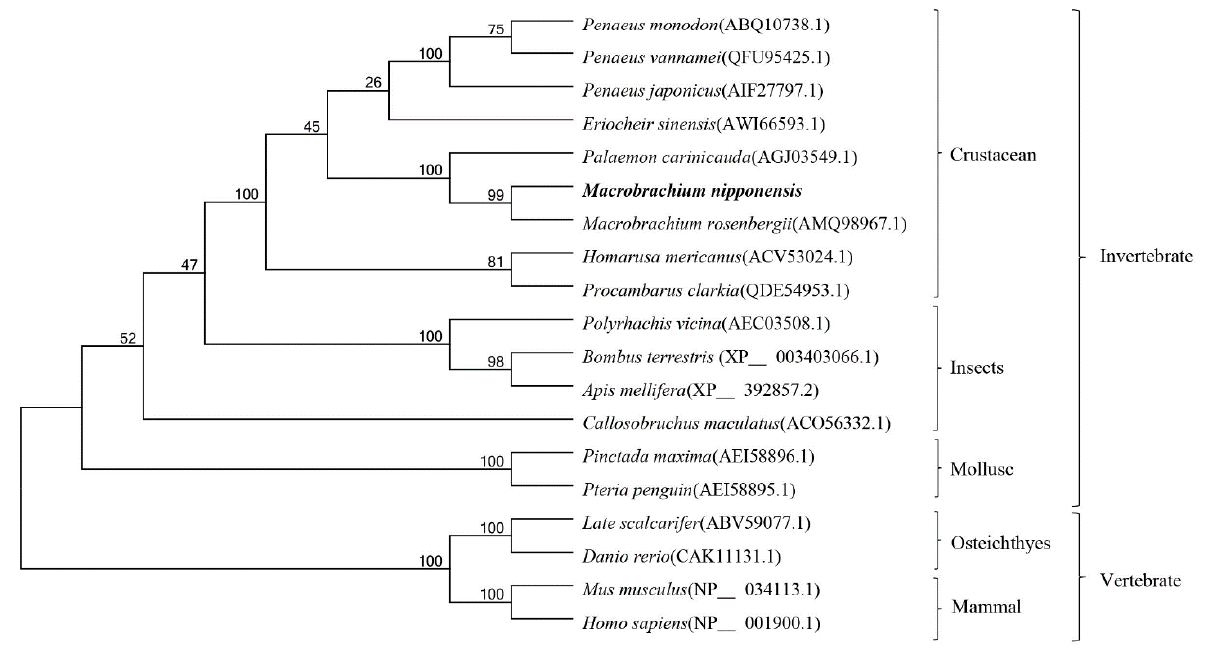
Figure 2. Comparison of Mn-CTSD derived amino acid sequences with cathepsin D from other crustaceans. Sequence uniformity is shown in black, with pink indicating conservative variation. N-glycosylation sites are marked by red arrows, aspartic protease signature sequences are marked by red boxes, and non-digestive cathepsin D signature sequences are marked by yellow boxes.